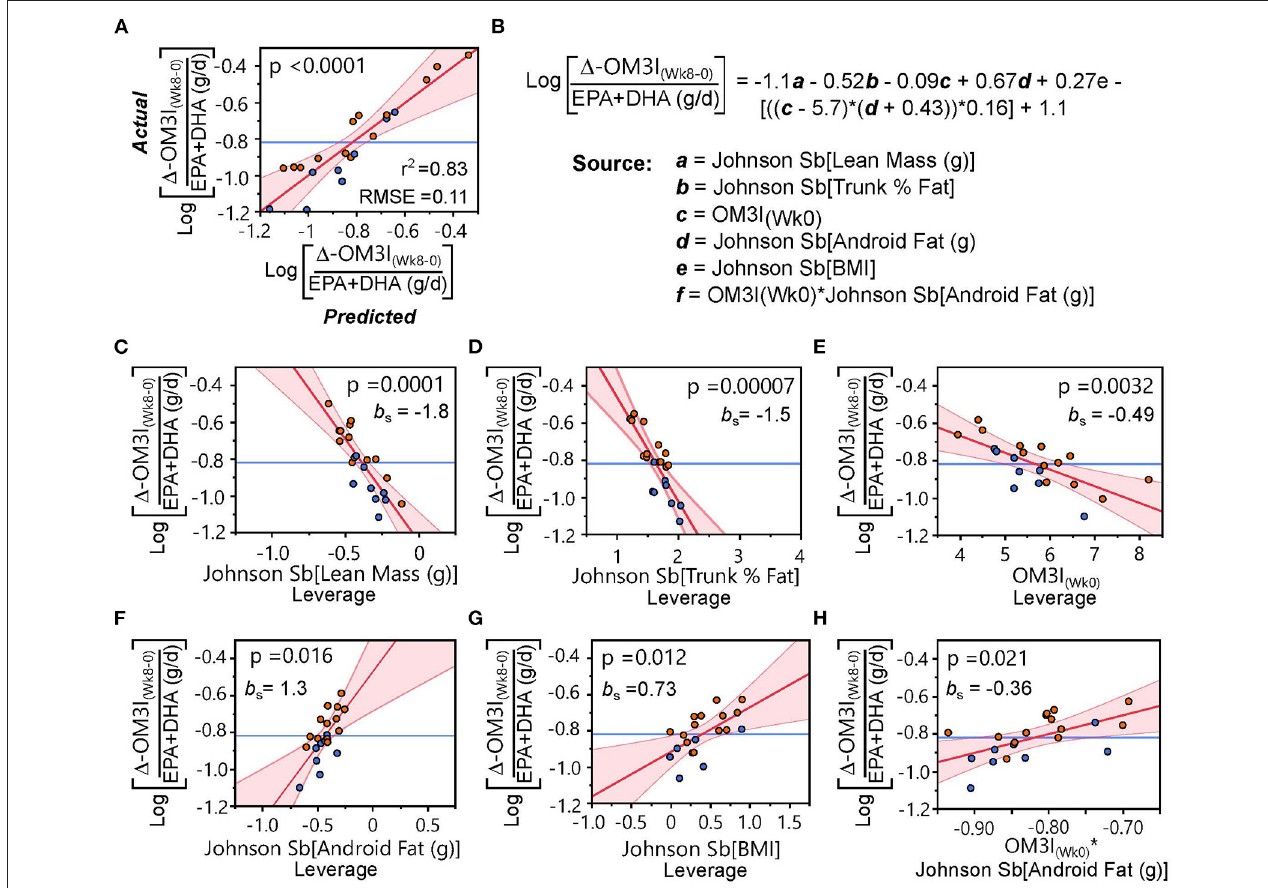
FIGURE 4 | Body composition and the baseline omega-3 index (OM3I (Wk0) ) explain the dose-dependent 8 wk change in the OM3I (Log[ 1 OM3I (Wk8 − 0) /(EPA + DHA)]). (A) Actual x Predicted plot from the stepwise linear regression of the Log[ 1 OM3I (Wk8 − 0) /(EPA + DHA)] using body composition factors and OM3I (Wk0) explaining 83% of the variance. (B) Regression equation and model components. (C–H) Leverage plots with p-values and the standardized beta coefficient ( b s ) for each model component: (C) lean body mass; (D) trunk %fat; (E) OM3I (Wk0) ; (F) android fat; (G) BMI; (H) OM3I (Wk0) × android fat interactions. Symbols: orange circles—high responding subgroup of the Dietary Guidelines for American Diet group defined in Figure 3B ; blue circles—low responding subgroup of the Dietary Guidelines for American Diet group defined in Figure 3B . b s , standardized beta-coefficient; RMSE, root mean square